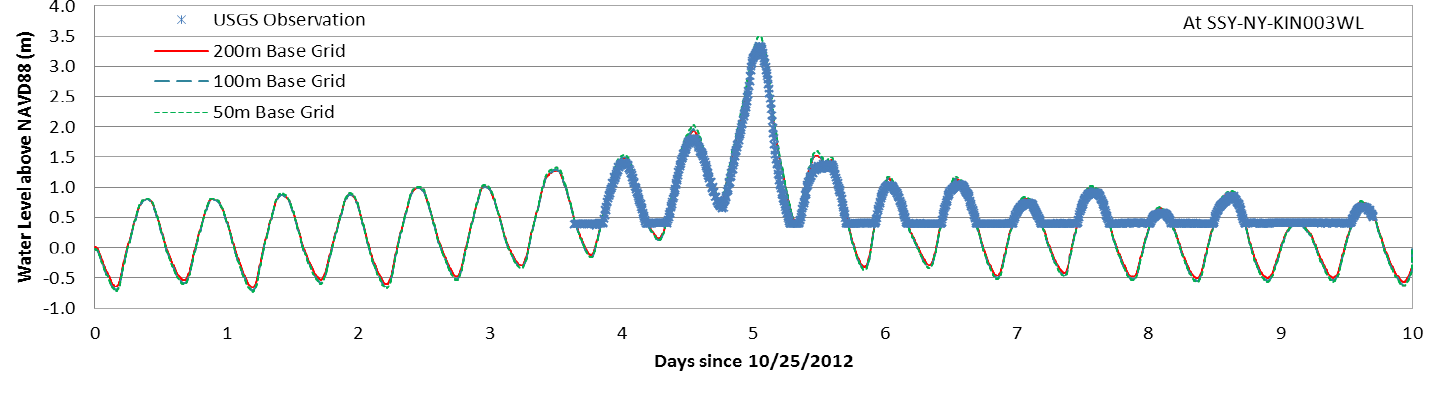
Figure 6. Water level comparison (top) with sub-grid, (bottom) without sub-grid at Gowanus Canal, Brooklyn, NY,